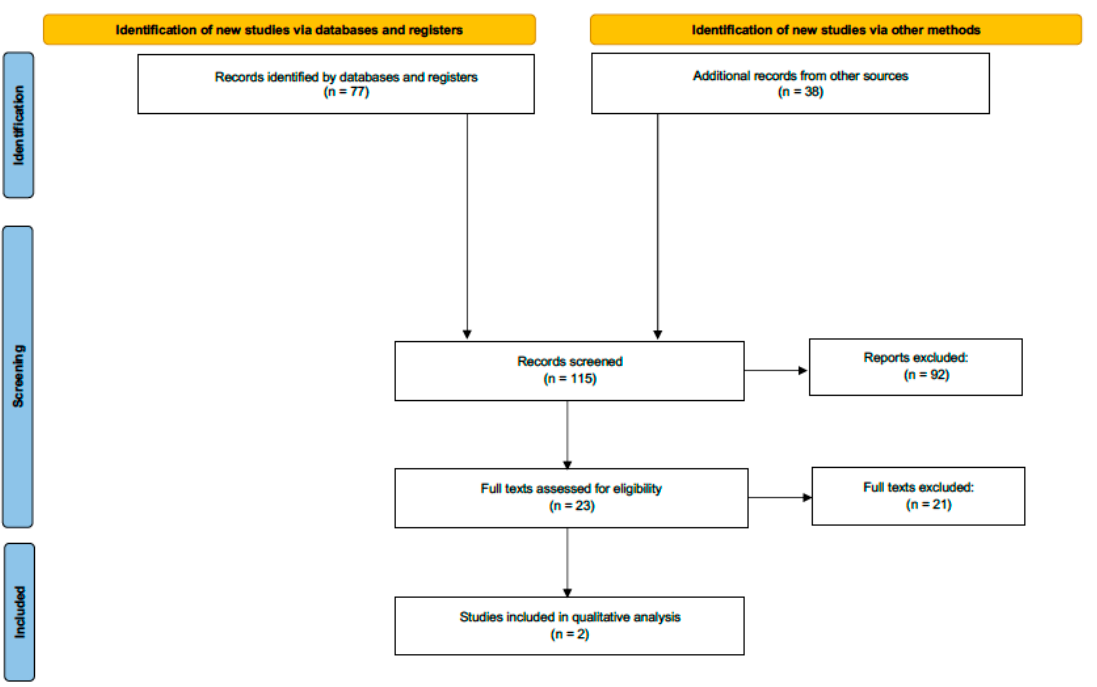
Figure 1. PRISMA flow diagram summarizing the retrieved, included and the excluded studies. PRISMA, Preferred Reporting Items for Systematic Reviews and Meta-Analyses.